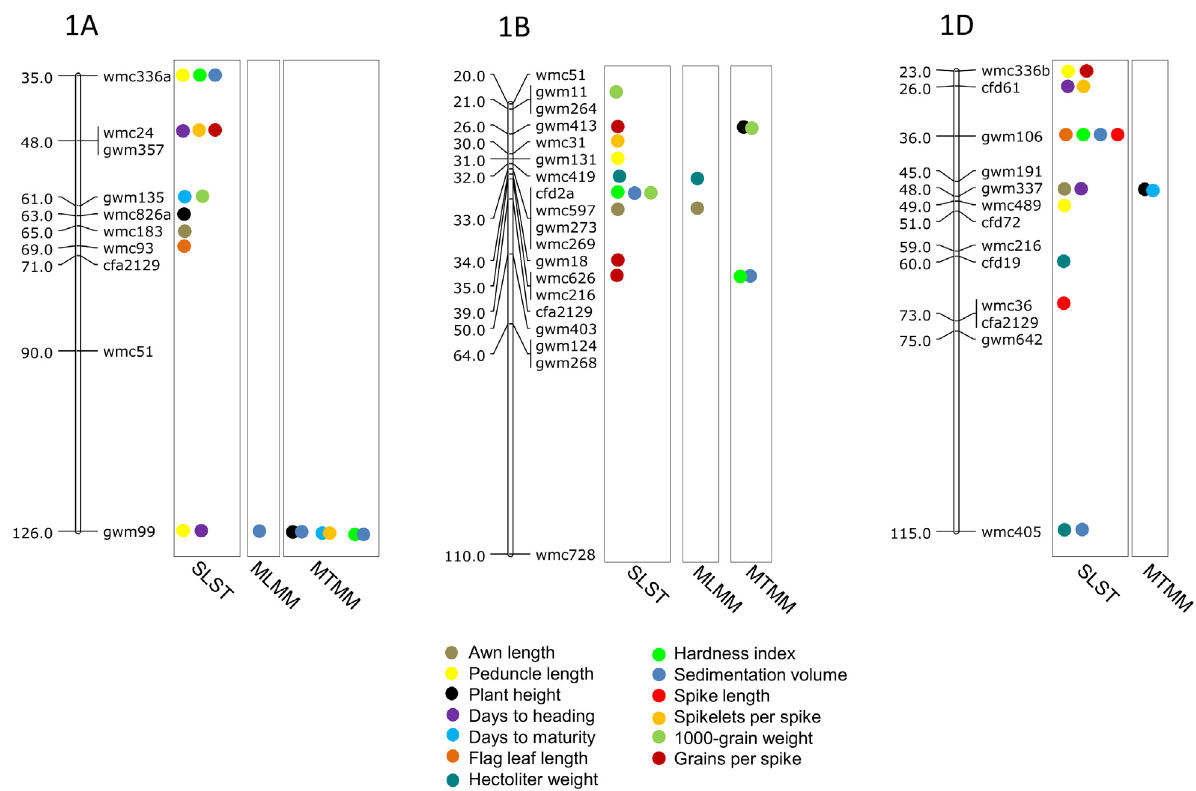
Fig 3. SSR genetic linkage maps of homoeologous group 1 chromosmes showing markers-trait associations (markers associated with different traits are shown by solid circles with different colours), markers are indicated to the right and map distances (cM) are indicated to the left of the vertical bar (based on the consensus linkage map of Somers et al. [76]).